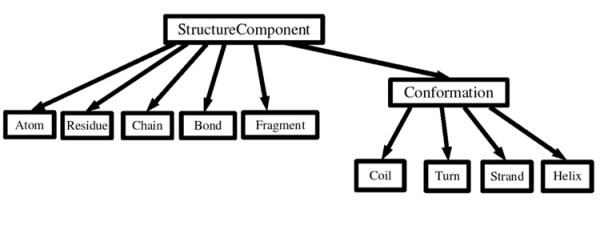
The MBT data model.